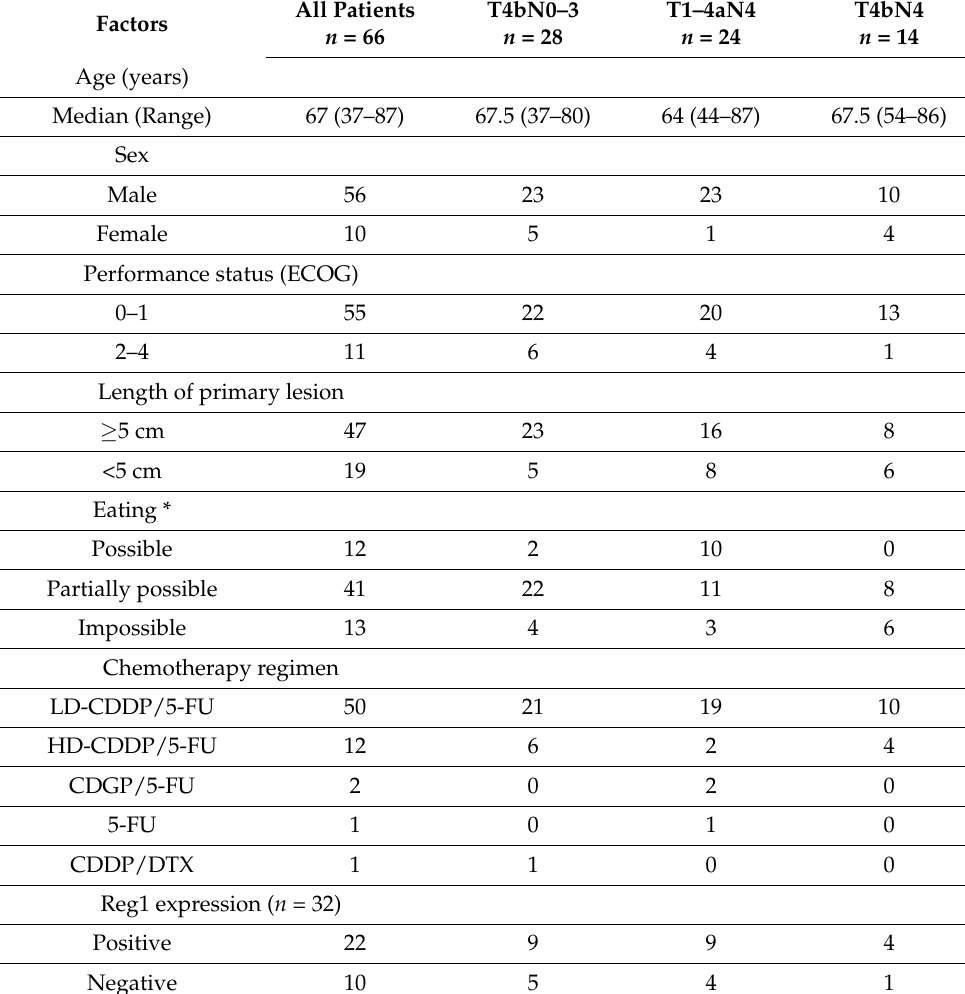
Table 2. Patient